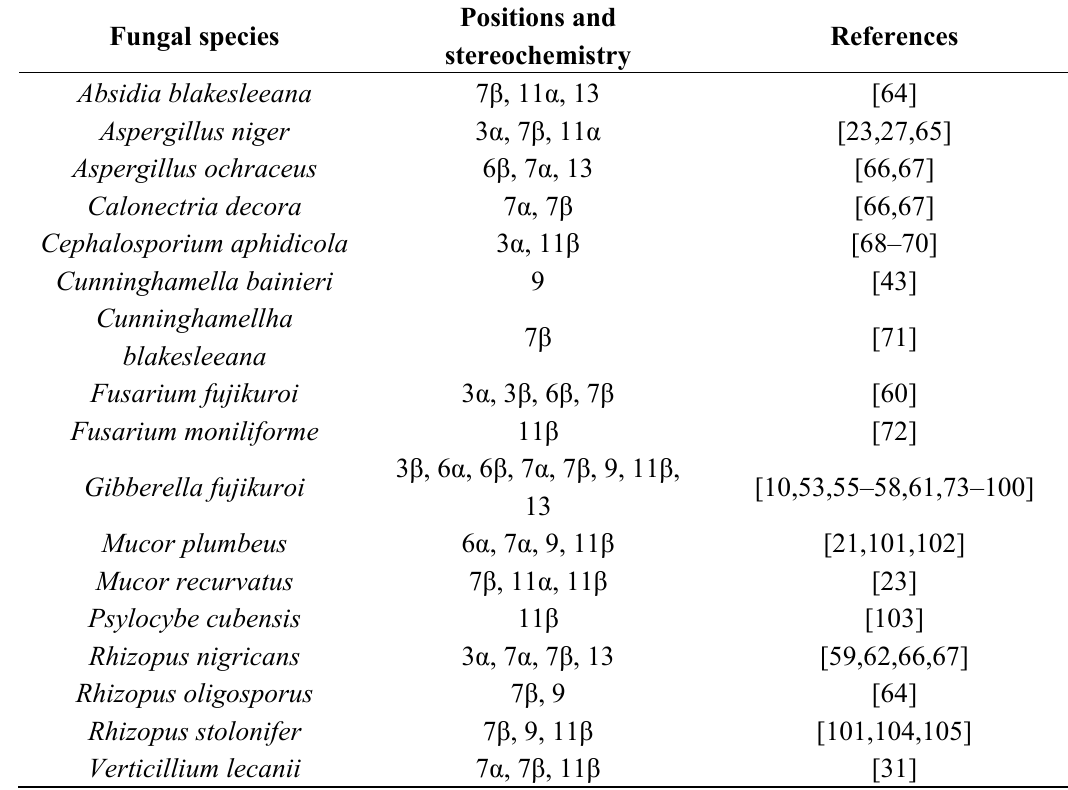
Table 2. Examples of fungi able to hydroxylate kaurane diterpenes, positions and stereochemistry of